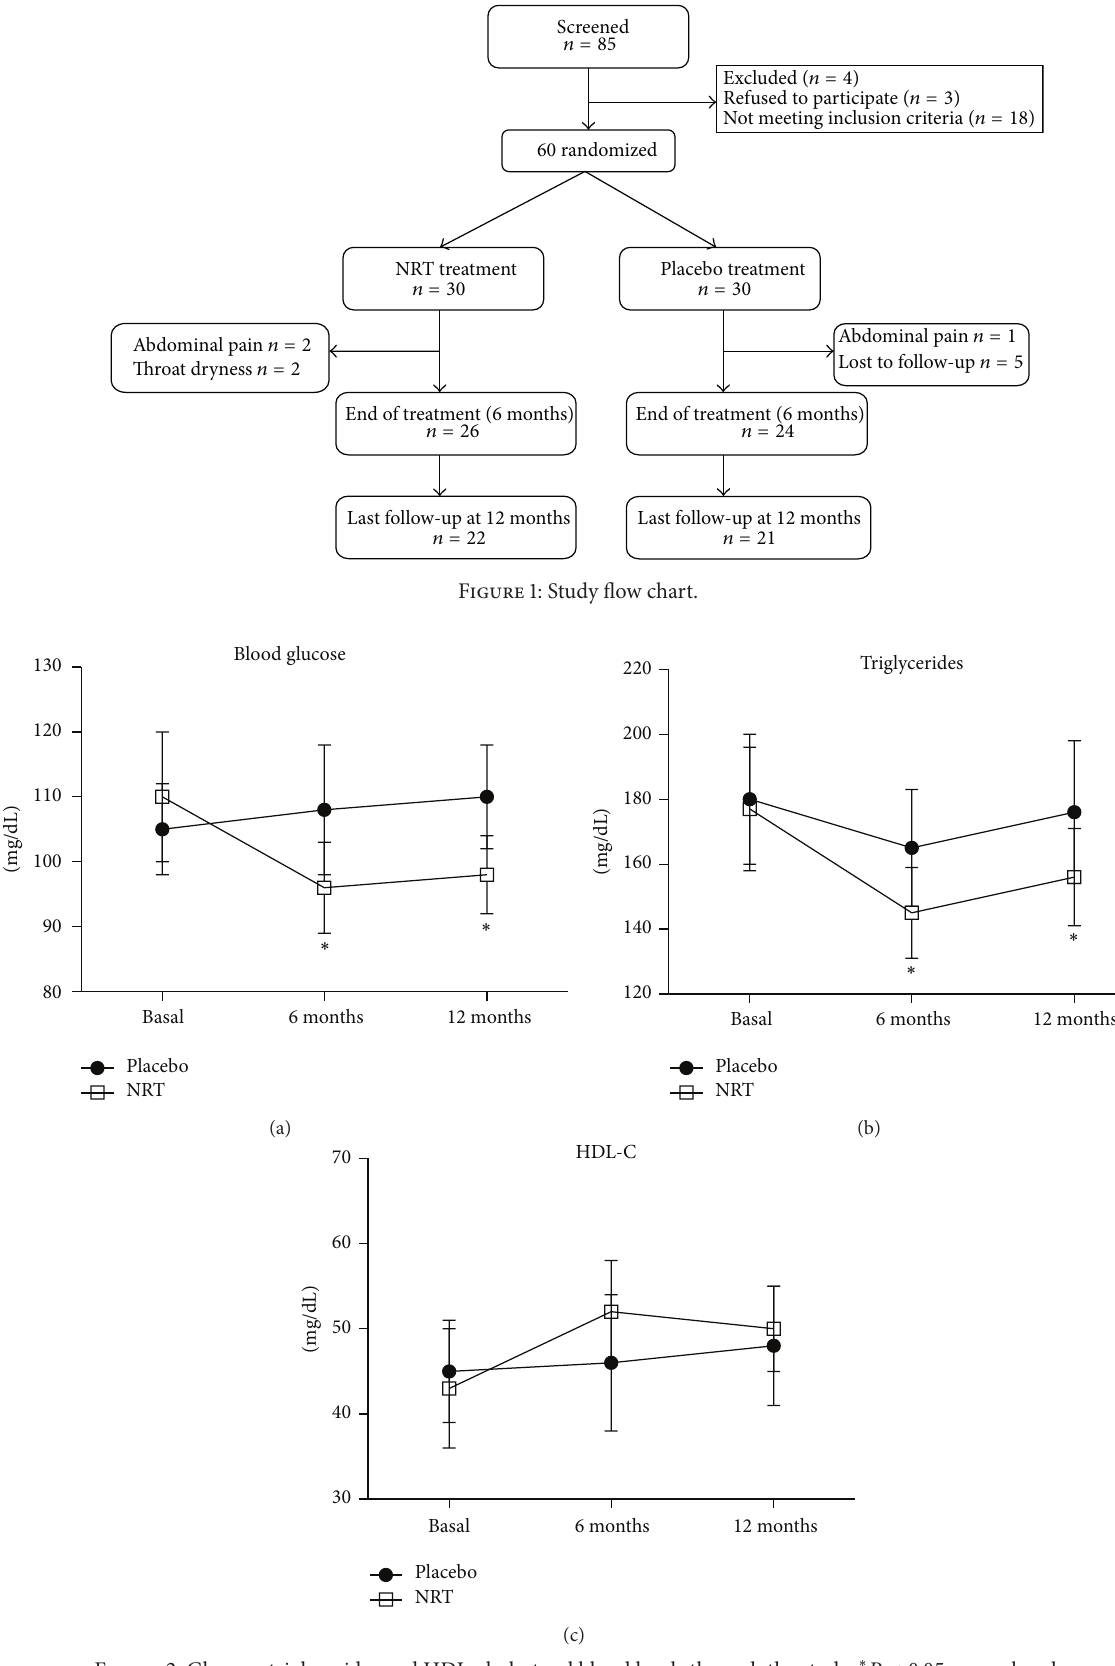
Figure 2: Glucose, triglycerides and HDL-cholesterol blood levels through the study. ∗ 𝑃 < 0.05 versus